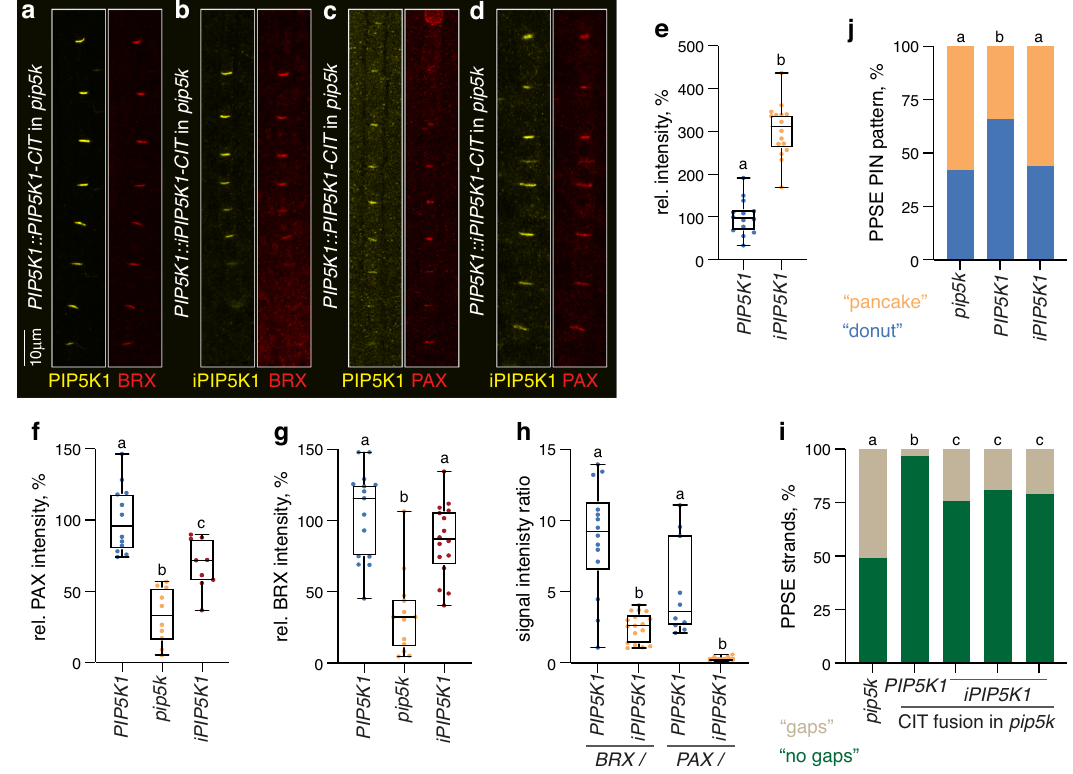
Fig. 2 | PIP5K can serve as a scaffold in developing PPSEs. a – d Confocal micro- scopy images of BRX (a-b; anti-BRX immunostaining, red fl uorescence) and PAX ( c , d ;anti-PAXimmunostaining,red fl uorescence)indevelopingPPSEsof5-day-old pip5k seedlings expressing either PIP5K1 ( a , c ) or iPIP5K1 ( b , d ) CIT fusion proteins (anti-GFP immunostaining, yellow fl uorescence) under control of the PIP5K1 pro- moter ( PIP5K1::PIP5K1-CIT and PIP5K1::iPIP5K1-CIT , respectively). e Relative abun- dance of the PIP5K1-CIT fusion protein variants ( a – d ) as determined by anti-GFP